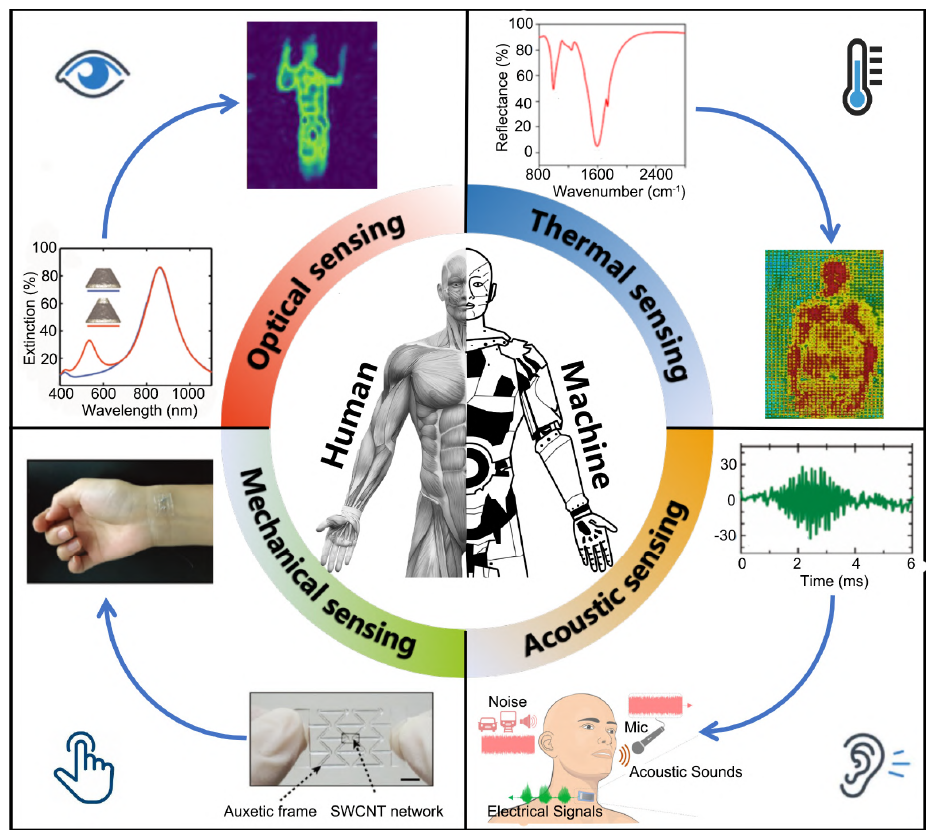
Figure 1. Metamaterial-enabled sensing for human-machine interfacing, including optical sensing, Figure 1 thermal sensing, acoustic sensing, and mechanical sensing, respectively. In each quadrant, the sensing signals and typical HMI applications are